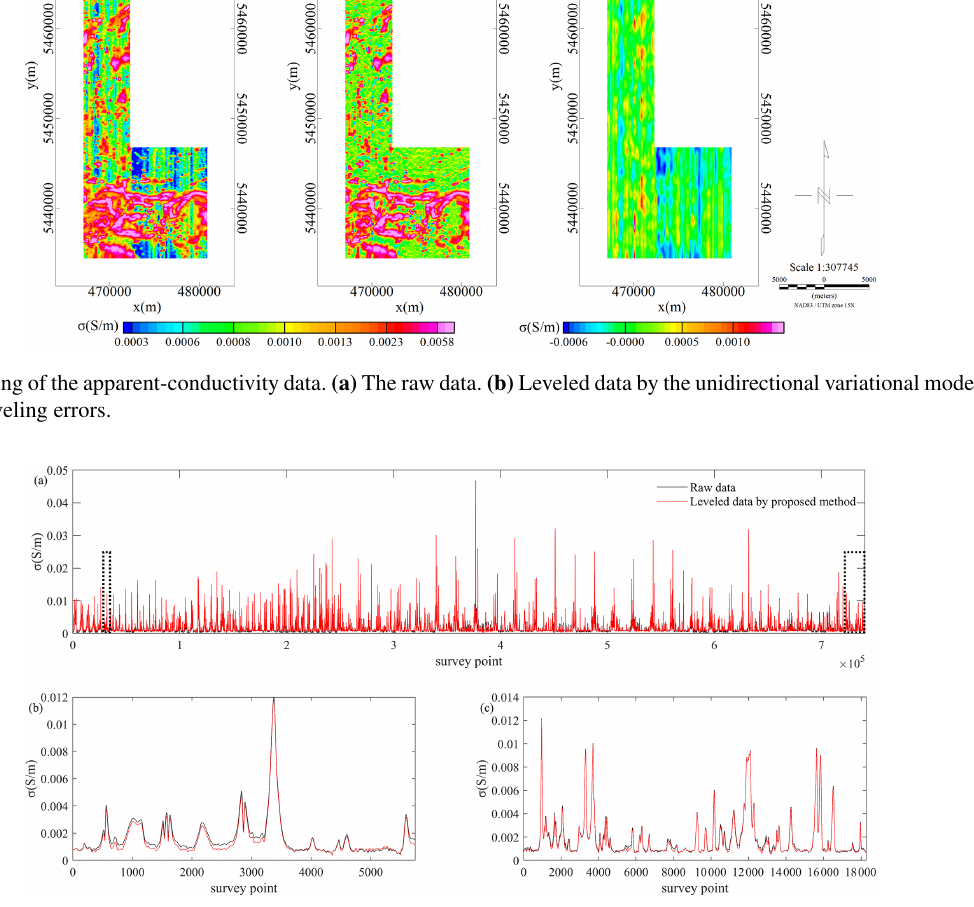
Figure 8. Leveled apparent-conductivity data. (a) All flight line data. (b) The sixth flight line data, corresponding to the first black dotted rectangle in (a) . (c) The 71st flight line data, corresponding to the second black dotted rectangle in (a)